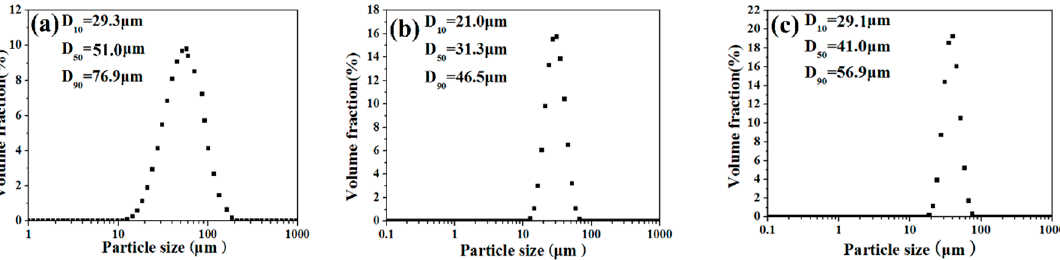
Figure 7. The size distributions and XRD patterns of mixture powders ( a ) Mo-B-Co-Cr, ( b ) Mo-B-Ni-Cr, and ( c ) Ti-B-Co-Cr.